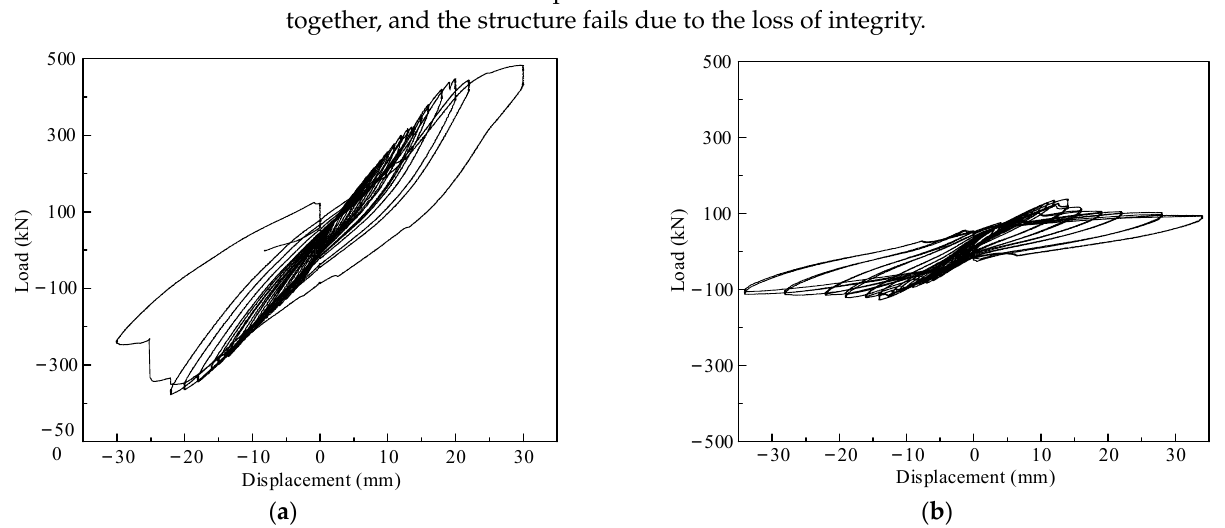
Figure 11. Hysteresis curve of the specimen. ( a ) L-shaped specimen; ( b ) T-shaped specimen.